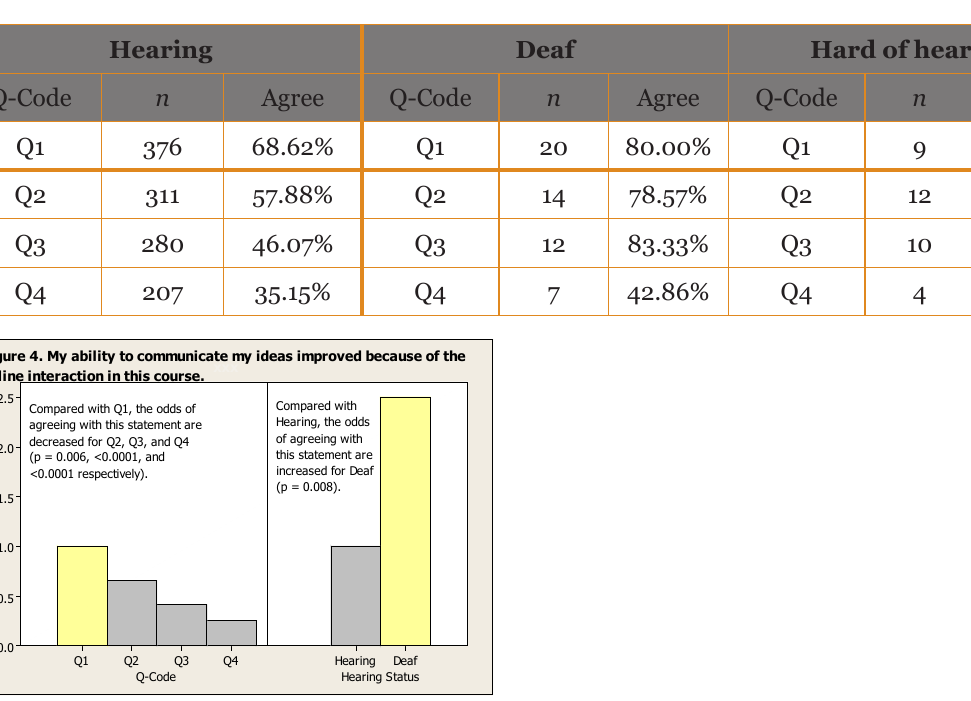
Figure 4 . Odds-Ratios for “My ability to communicate my ideas improved because of the online interaction in this